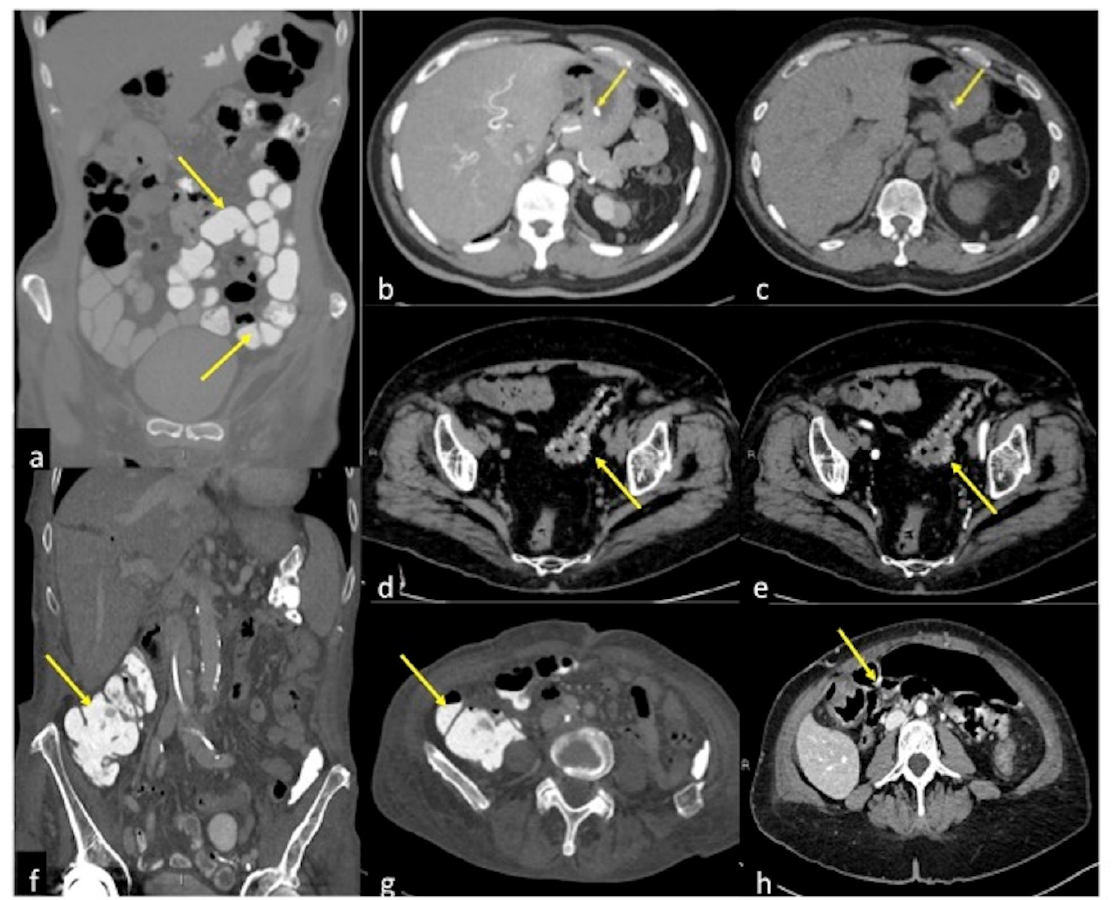
Figure 19. Pitfalls in the detection of acute gastrointestinal bleeding. ( a ) Positive contrast media administration (arrow): coronal CTA reconstruction of contrast media distended bowel loops (arrows) obscure any GIB source. ( b , c ) Endoluminal hyperdense ingested capsule: arterial and pre-contrast axial CTA image of an endoluminal hyperdense ingested capsule in patients with melaena. In the arterial phase with MIP post-processing ( b ), an endoluminal hyperdense inclusion is detected (arrow) in the gastric lumen; the pre-contrast phase ( c ) confirms the presence of the inclusion with analogous morphologic and densitometric characteristics (arrow). ( d , e ) Retention of contrast media in patients with diverticulosis and haematochezia: pre-contrast ( d ) and arterial ( e ) axial CTA images show unchanged hyperdense diverticula ( d , e , arrow). ( f , g ) Hyperdense fecaloma: coronal ( f ) and axial ( g ) CTA image of hyperdense fecaloma ( f , g , arrow) due to retained contrast media. ( h ) Cone-beam artefacts: axial arterial CTA image shows massive hyperdensities within the bowel lumen (arrow) due to cone-beam artefacts.